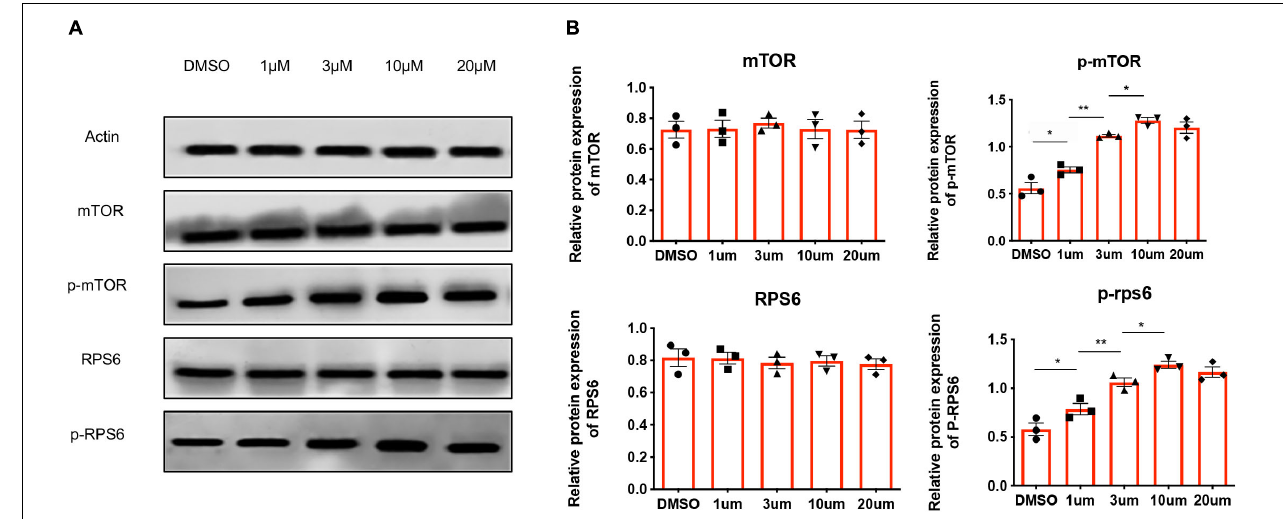
FIGURE 1 | MHY1485 treatment can stimulate the phosphorylation of proteins in the mTOR pathway. (A) Treatment of 1 µ M, 3 µ M, and 10 µ M MHY1485 led to a dose-dependent increase in the phosphorylation of mTOR as well as downstream RSP6 protein levels without affecting total mTOR rpS6 expression. Treatment of 20 µ M did not increase those protein levels further in comparison to 10 µ M MYH1485. (B) Experiments were repeated three times. All data were compared with that of the control group. Data was applied to non-parametric tests for statistical analysis and presented as the mean ± SEM * P < 0.05, ** P < 0.01, and the differences are